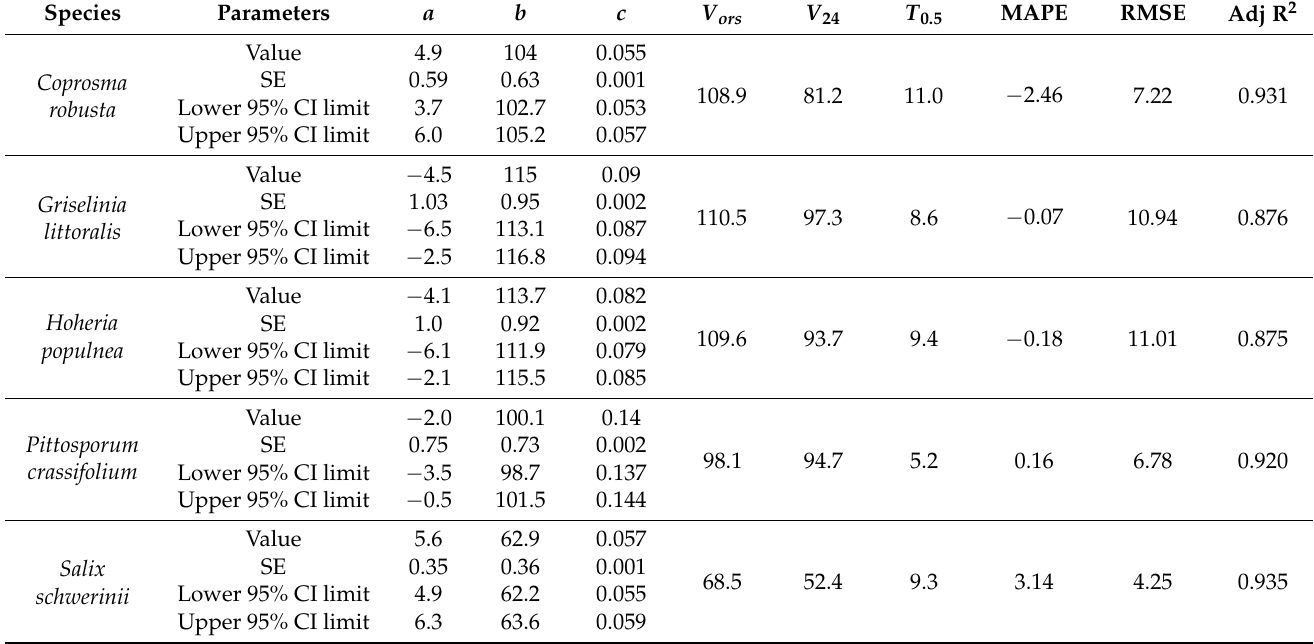
Table 6. Native ( Coprosma robusta , Griselinia littoralis , Hoheria populnea , and Pittosporum crassifolium ) and exotic ( Salix schwerinii ) shrub species stem in vitro fermentation kinetic parameters derived using single-pool model, where: a , gas production from the immediately soluble fraction (mL/g DM); b , gas production from the slowly degradable fraction (mL/g DM); c , rate of gas production (%/h); V ors , total gas production (mL/g DM); V 24 , total gas production after 24 h (mL/g DM); and t 0.5, half-life of total gas production (h).